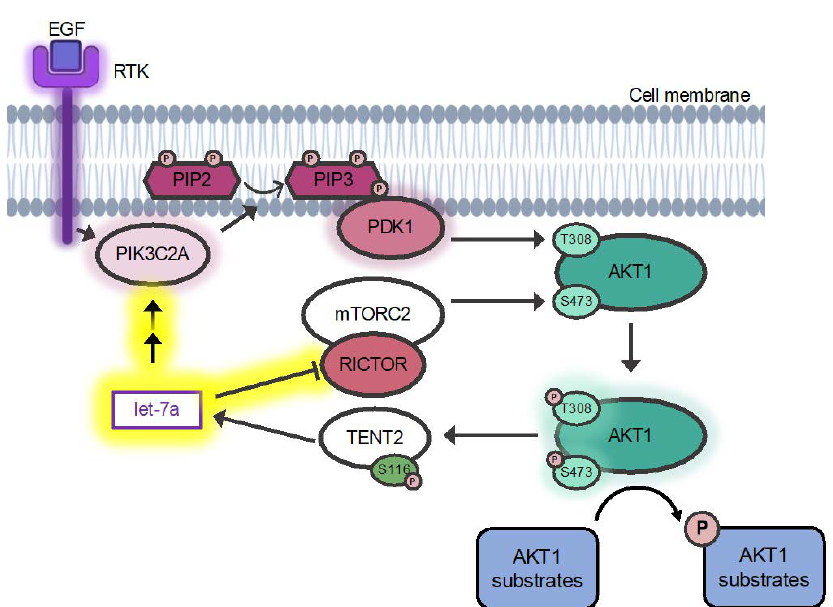
Figure 1. miRNA let-7a and epidermal growth factor stimulation control AKT1 phosphorylation by regulating PIK3C2A and RICTOR. Overview of the PI3K/AKT pathway and contributions of let-7a.